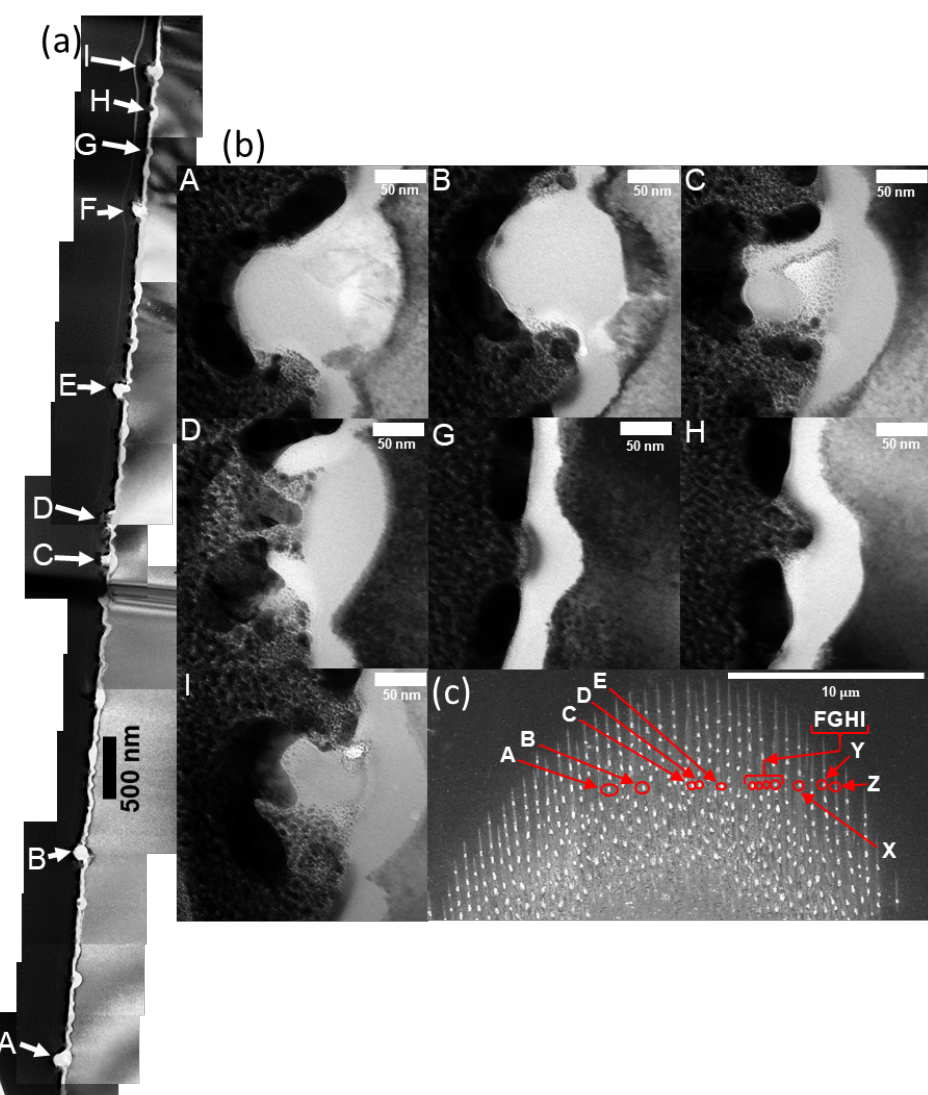
Figure 11. High resolution cross-sectional TEM measurements of multi-pulse nanostructure forma- tion on silicon. ( a ) TEM images of a wide area have been stitched together. Areas of interest are marked by an upper-case letter. Area A is near the end of the sample (see Figures 5 and 6); ( b ) several of the features from ( a ) are shown magnified. They are labeled by the corresponding capitol letter locator in the top left corner; ( c ) the sample location for each feature is labeled in an overhead SEM of the site taken prior to any FIB/TEM